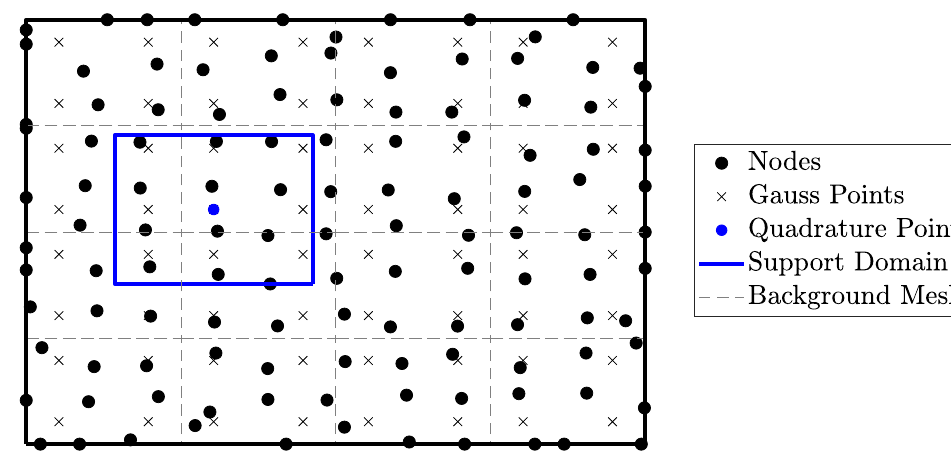
Figure 1. Example of support domain, background mesh, Gauss integration